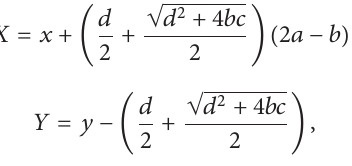
characteristics of the chaotic system once again: bounded- ness and ergodicity. Therefore, there are some methods which can be taken to control the chaos and